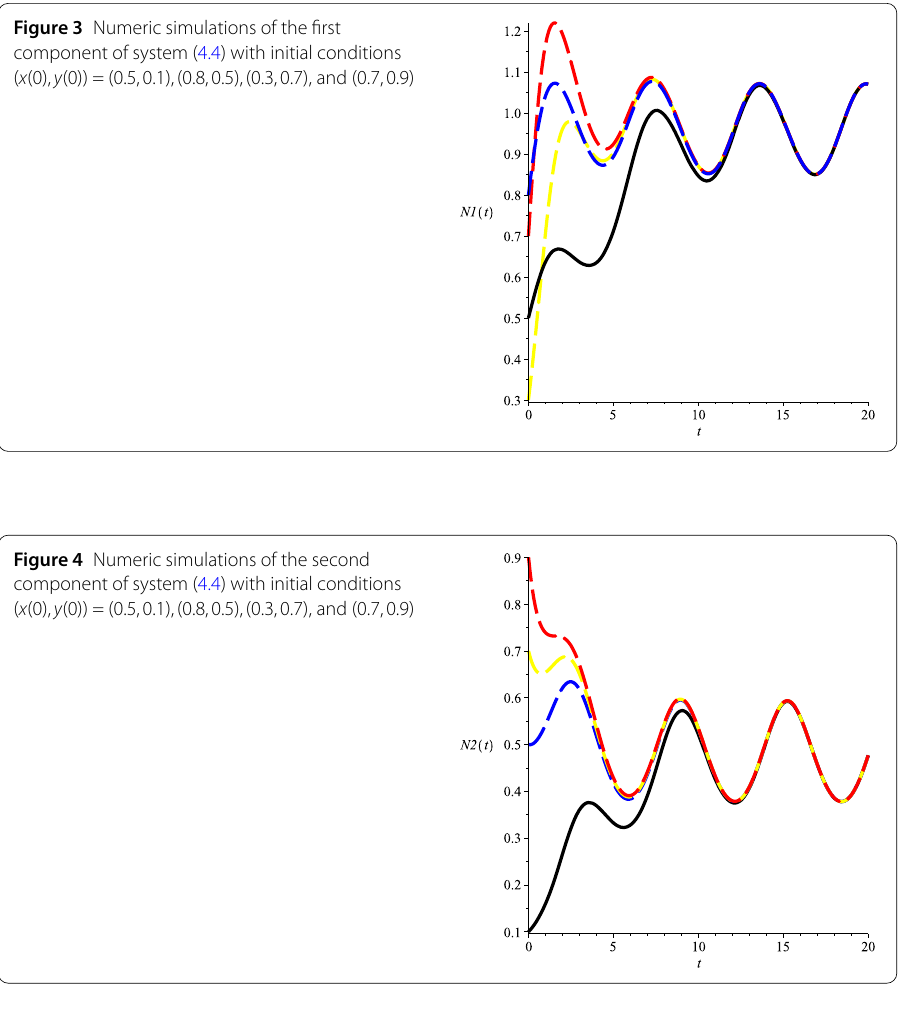
Figure 3 Numeric simulations of the first component of system (4.4) with initial conditions